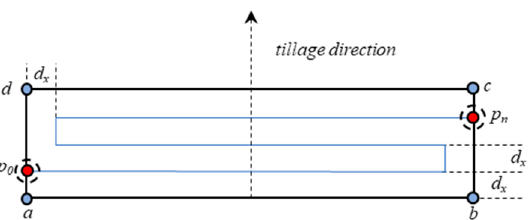
Figure 7. A diagrammatic representation of the suggested edge-vertex path algorithm for walking behind a hand tractor. The algorithm regularly adds points by recognizing the lines’ intersection with a predefined region of interest (ROI).